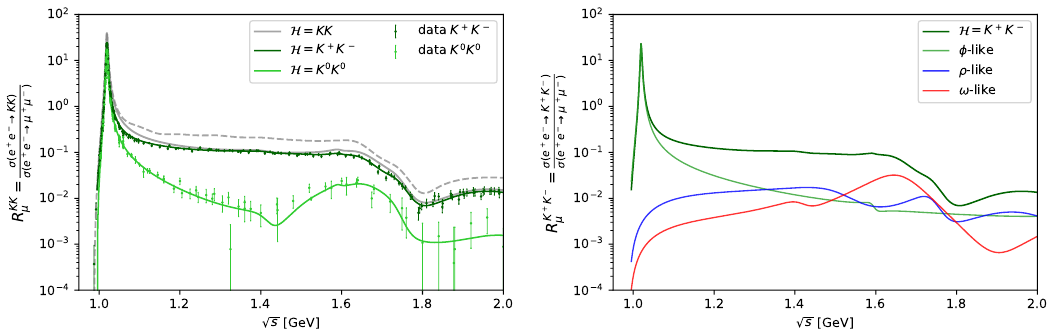
for the H = KK channel. In the left panel the solid Figure 17 . Normalized cross-section R H µ (dashed) gray line indicates our ( DarkCast ) total KK calculation, while the dark (light) green line indicated our fit for the K + K − ( K 0 ¯ K 0 ) channel. The data points correspond to a compilation from several experiments [48–57]. In the right panel we show the decomposition of the charged K + K − channel (dark green) into ρ (blue), ω (red) and φ (green)